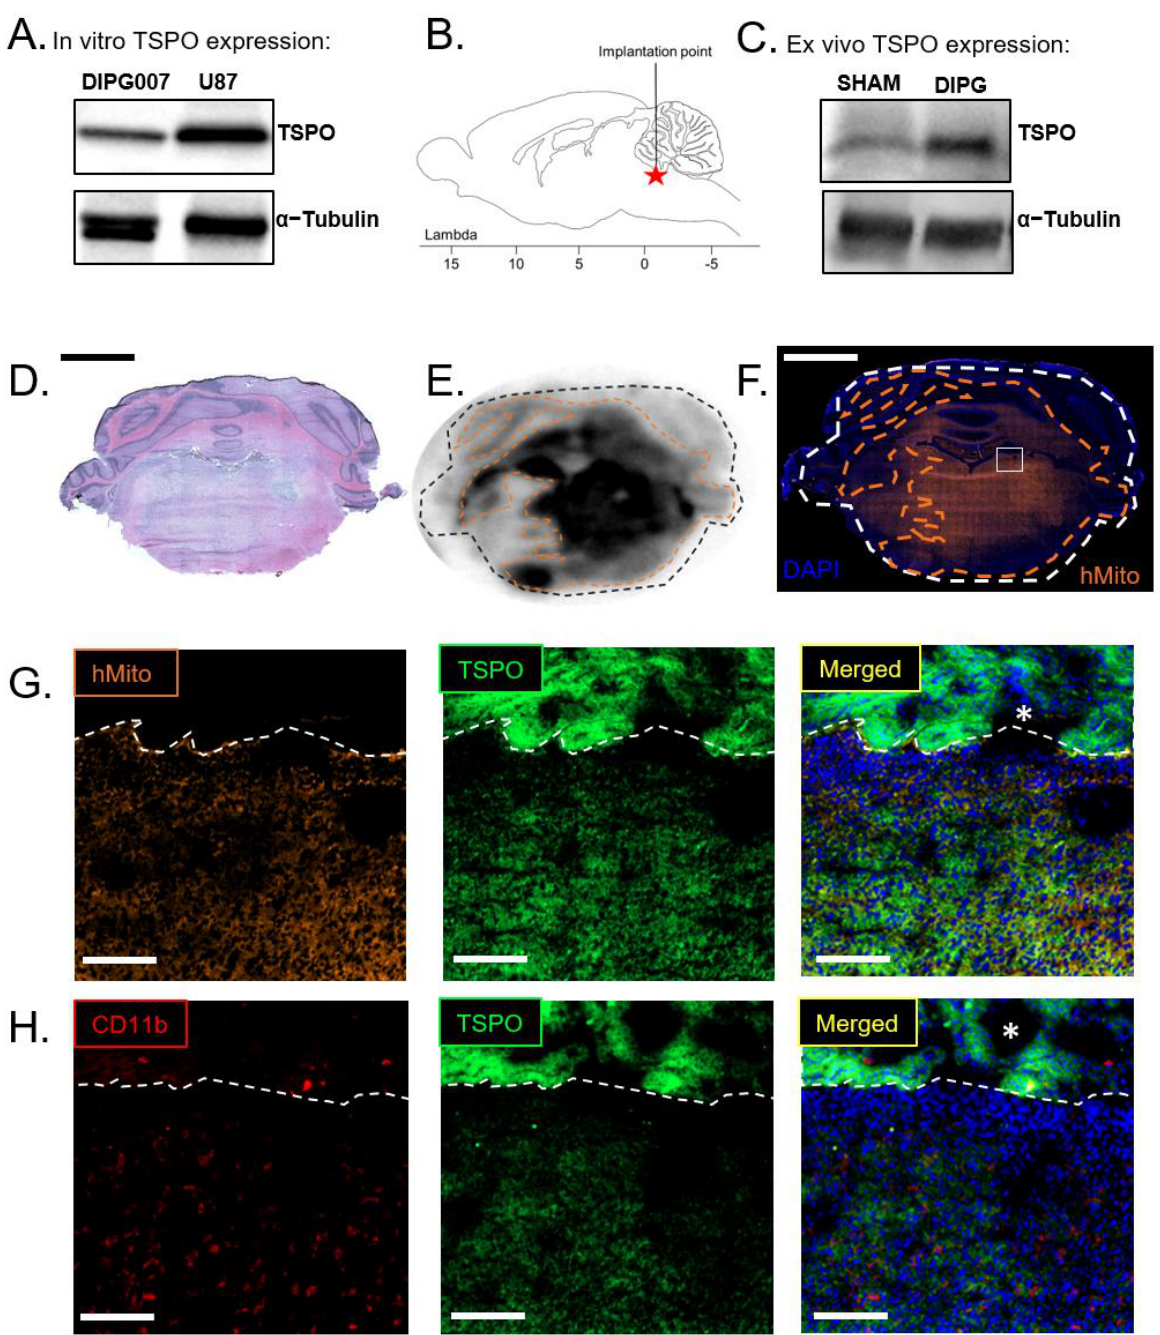
Figure 1. In vitro and ex vivo TSPO expression of HSJD-DIPG-007 cells. ( A ) In vitro DIPG007 and U87 TSPO expression as revealed by Western Blot. ( B ) Implantation point to establish the orthotopic DIPG murine model. ( C ) Ex vivo TSPO expression in the back brain of sham and DIPG007 cell- bearing rats as revealed by western blot. Western blot quantifications are available in Supplementary Materials (Figure S6). ( D , E ) Hematoxylin/eosin staining and 18 F-DPA-714 autoradiography of the same brain section. ( F ) Human mitochondria immunostaining on an adjacent section. The orange contour is the area where fixation of 18 F-DPA-714 on the autoradiography is observed. ( G ) TSPO and human mitochondria immunostaining in a tumoral area near the IVth ventricle indicated by the white box on F. ( H ) TSPO and CD11b immunostaining in a tumoral area near the IVth ventricle. Stars (*) indicates the IV th ventricle ependymal cells. Scale bars = 2.5 mm ( D , F ) and 150 µ m ( G , H